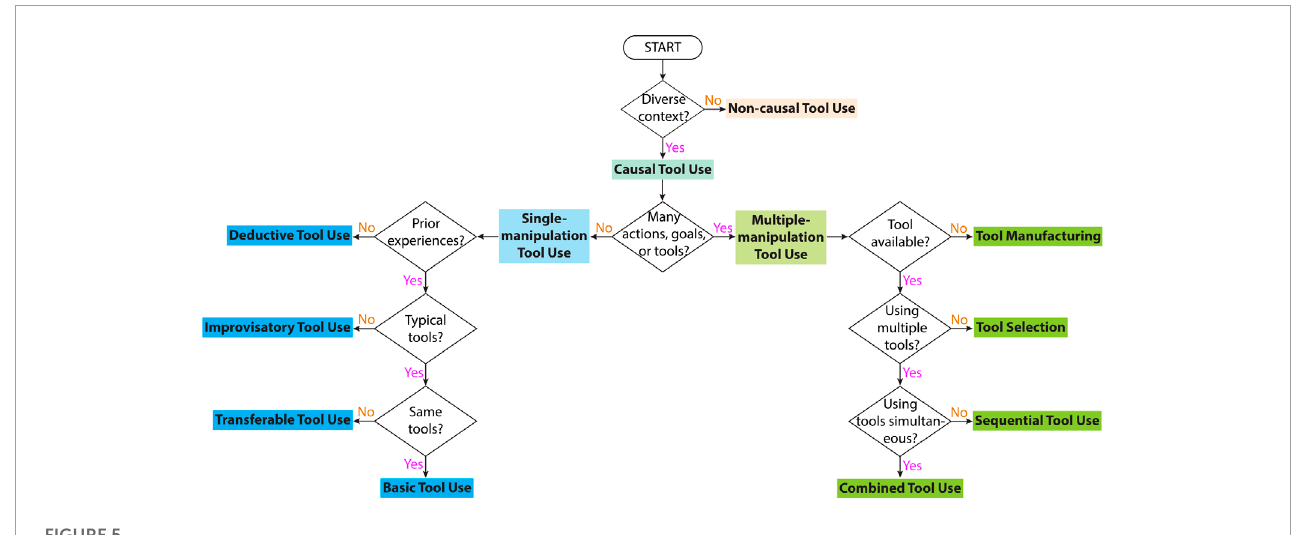
the application. We include a convenient cheat sheet for engineers as Figure 5 . Upon the identification of the sub-type, our taxonomy